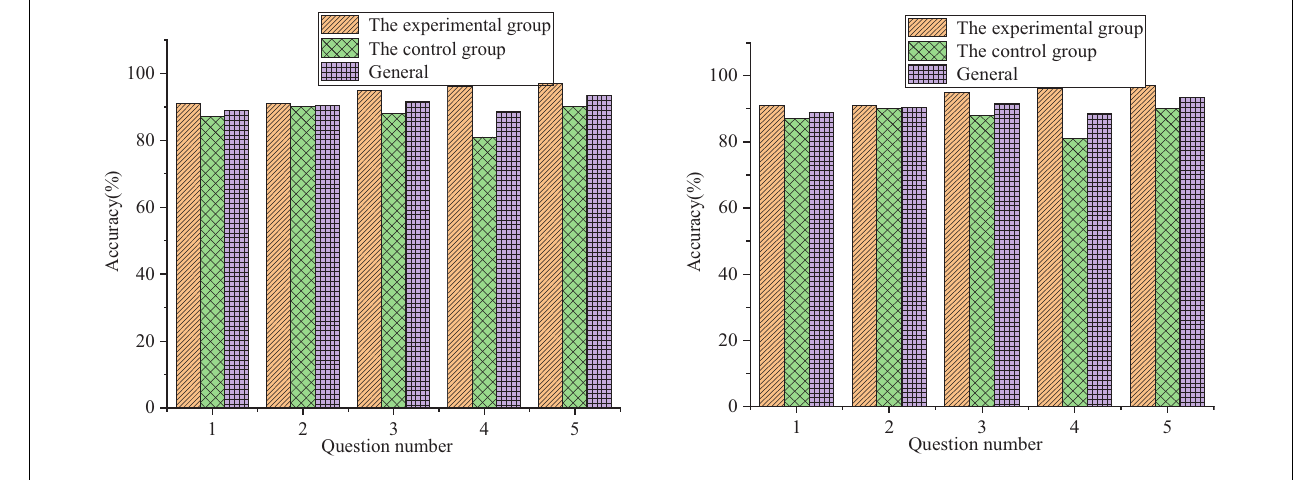
FIGURE 7 | Statistical analysis of the accuracy of multiple-choice questions.